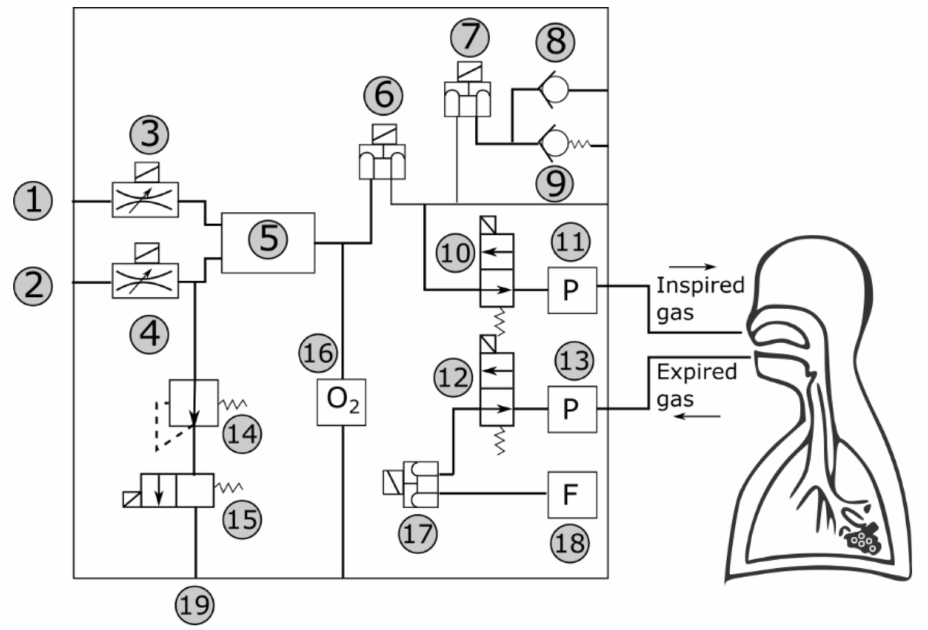
Figure 1. Components of a mechanical ventilator for use with a network of oxygen and medical air in an ICU. The components are detailed in